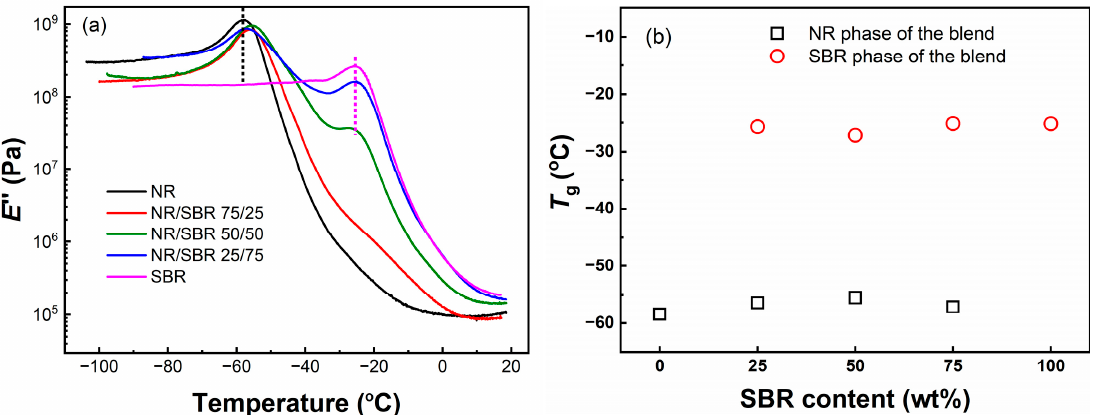
Figure 2. ( a ) Loss modulus E ′′ as a function of temperature for NR/SBR blends. ( b ) Glass transition temperature T g as a function of SBR content for NR/SBR blends.